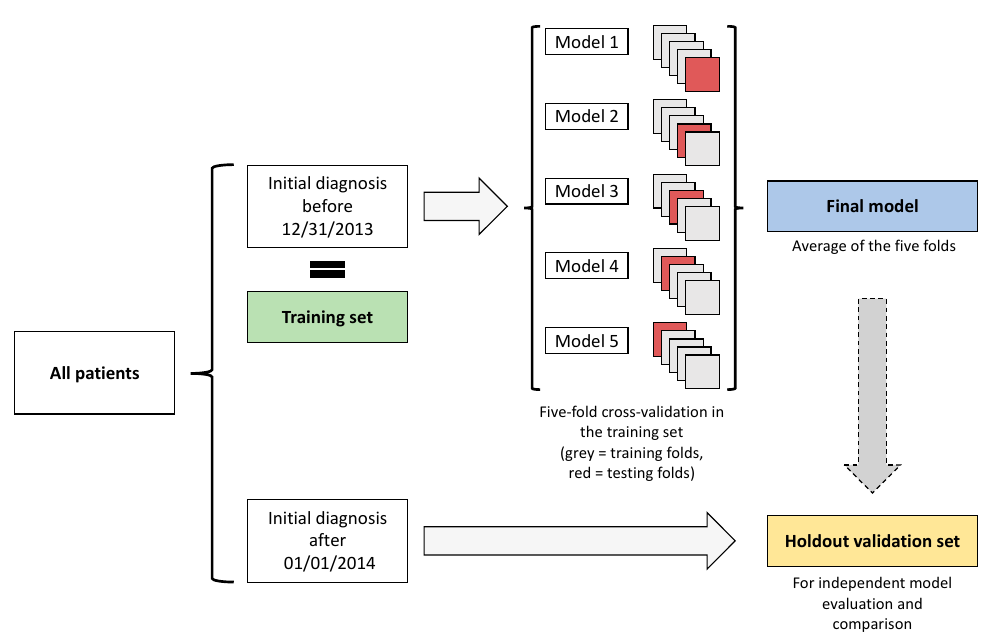
Figure 4. Visualization of the created artificial neural network.